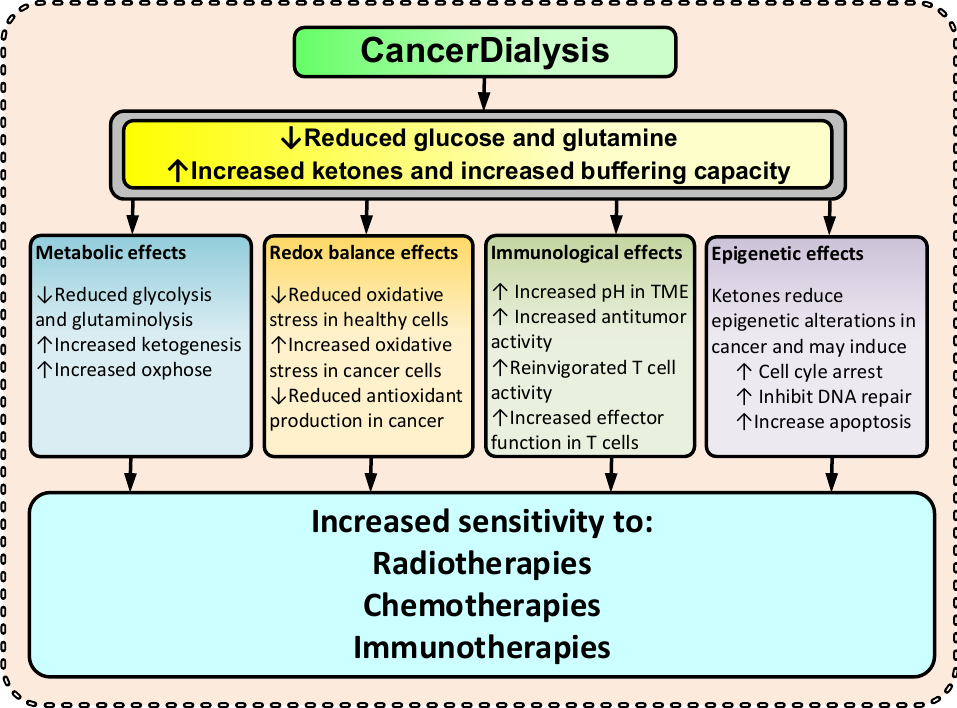
Figure 2. Suggested effects of CancerDialysis on the efficacy of TCT. ( ↑ ) indicates an increase and ( ↓ ) indicates a decrease.